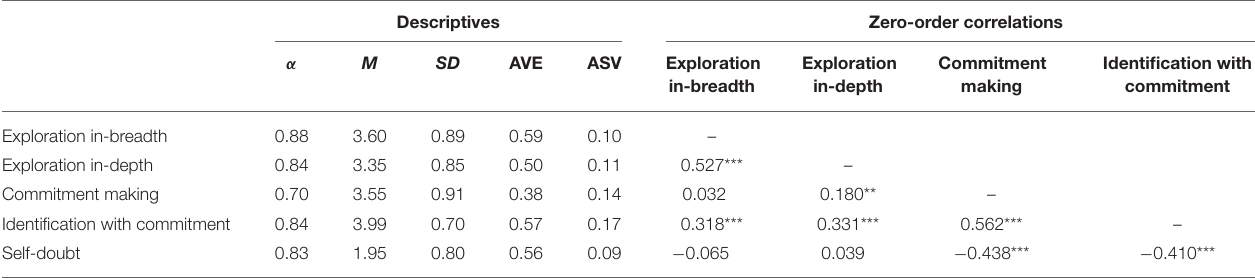
TABLE 1 | Descriptive statistics and internal validity of the pre-transition EIPS.